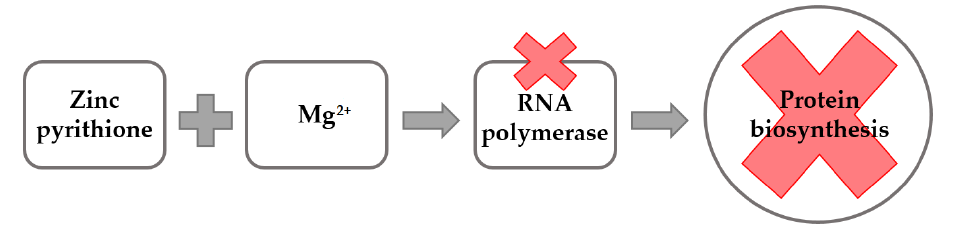
Figure 3. A diagram showing the effect of complex of zinc pyrithione with Mg 2+ on the process of protein biosynthesis.